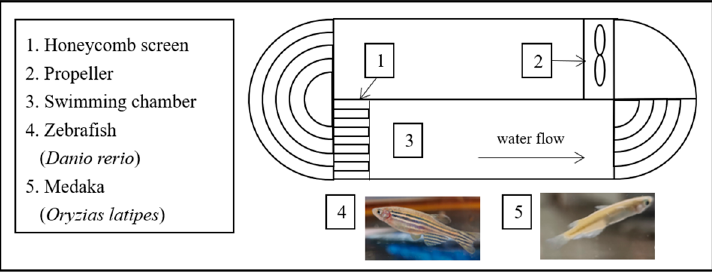
Figure 1. Sketch of the experimental setup in the laboratory.